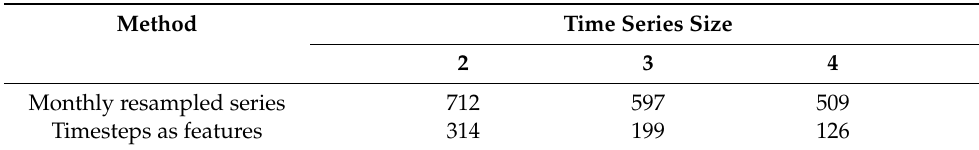
Table 2. Number of augmented time series depending on the sequential modelling approach and the size of each series.